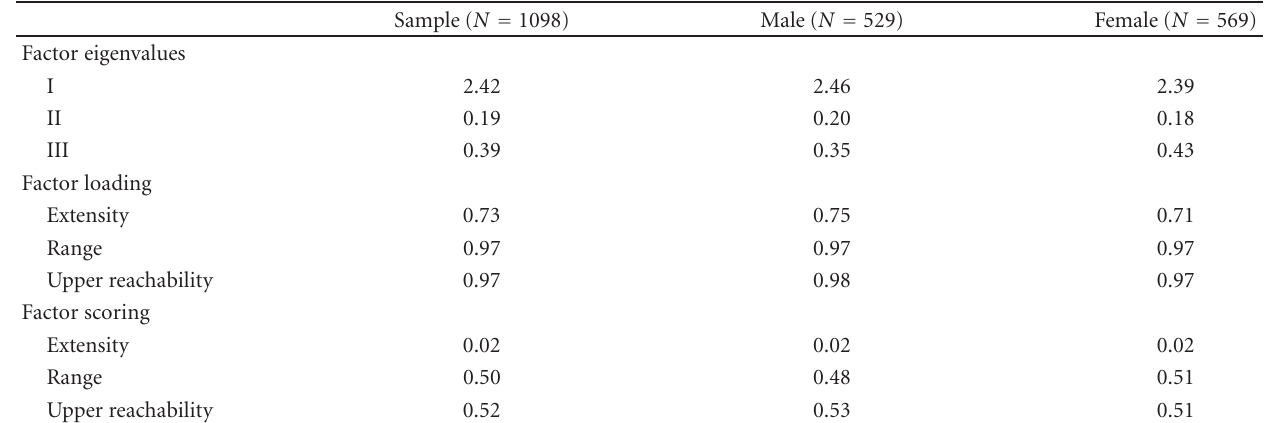
Table 2: Factor structures of access to social